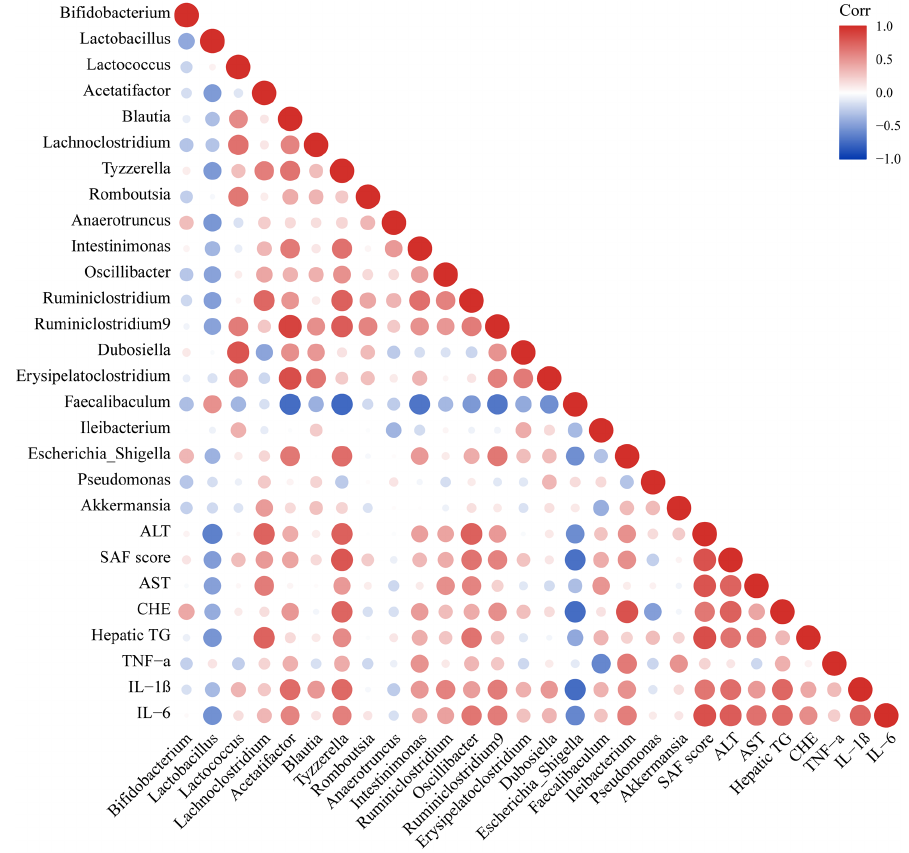
Figure 7. Correlation analysis between intestinal microbiota and liver